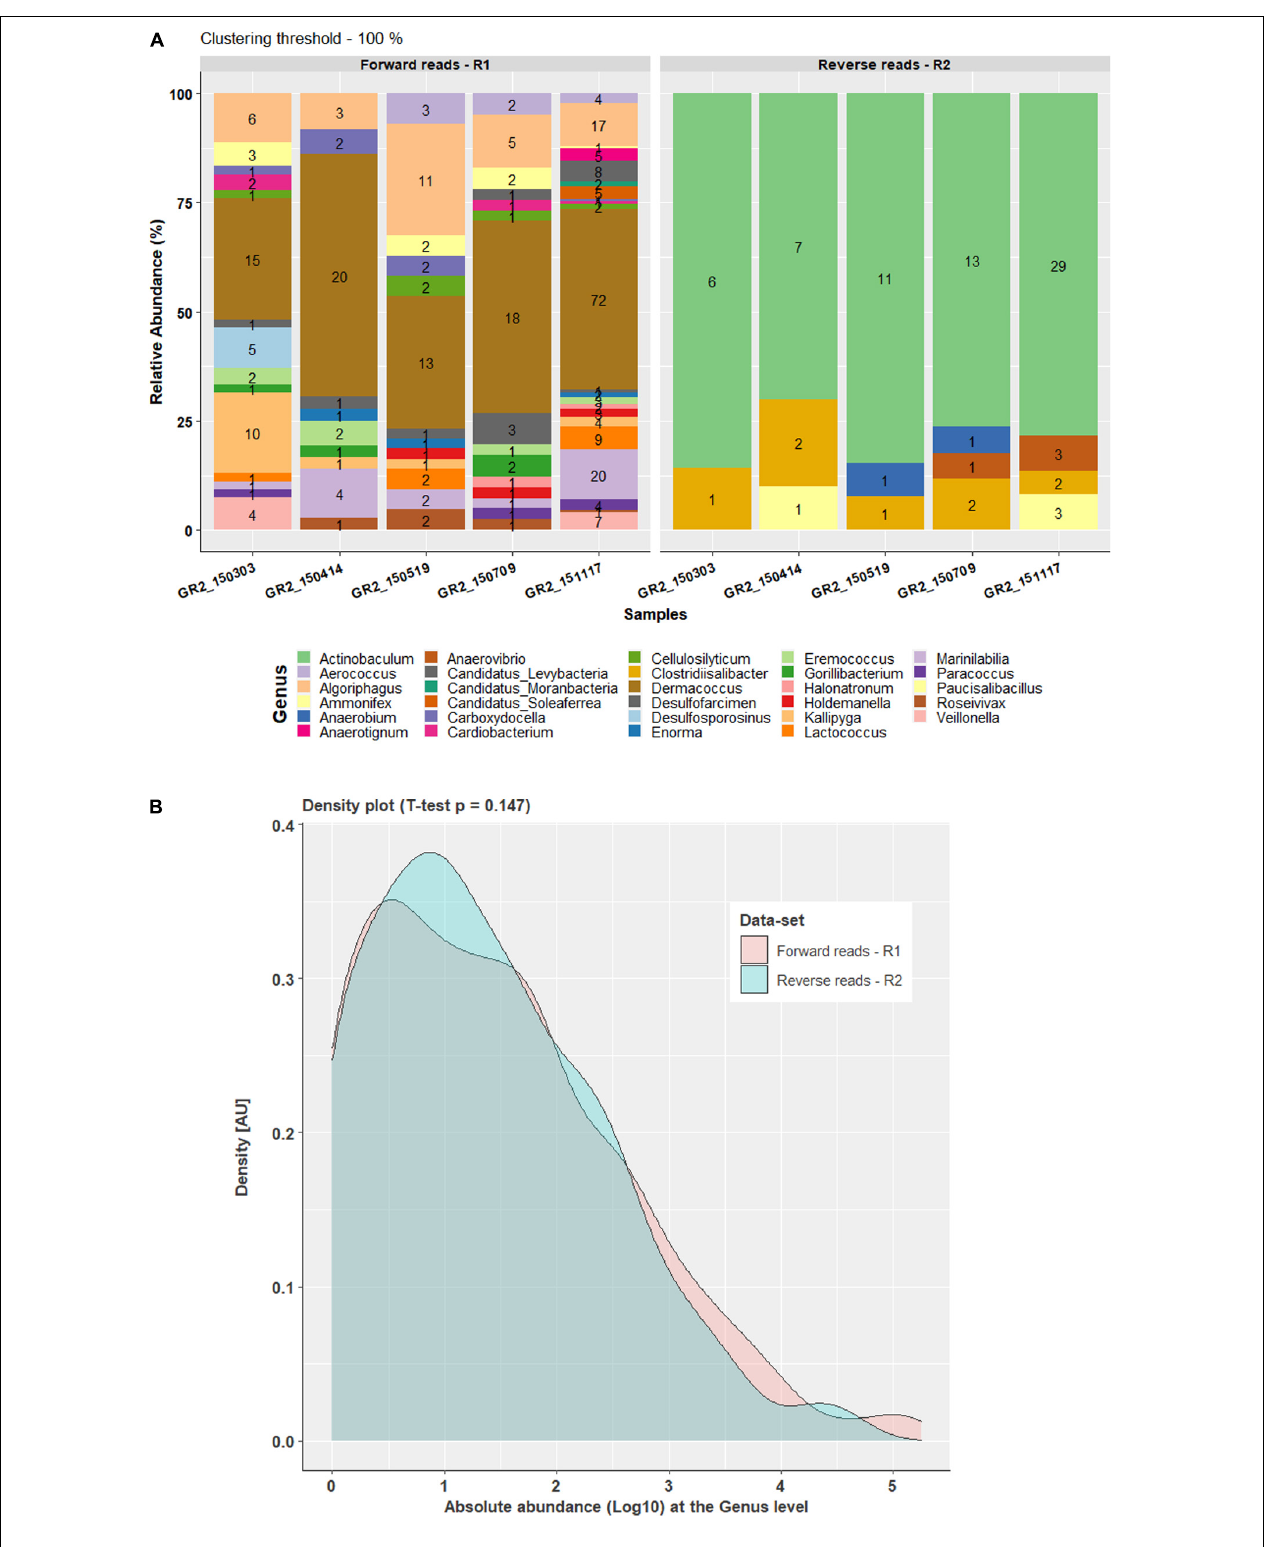
FIGURE 3 | Comparison of forward and reverse reads data-set at genus level with 100% clustering threshold. (A) Bar plot representing the percentage difference in the relative abundance of the unique OTUs for the forward and reverse taxonomy at the genus level, where values on the bars indicate the count of the respective OTU in the abundance table. (B) Density plot for comparison of log 10 -transformed complete datasets of the forward and reverse read absolute abundance at the genus level.